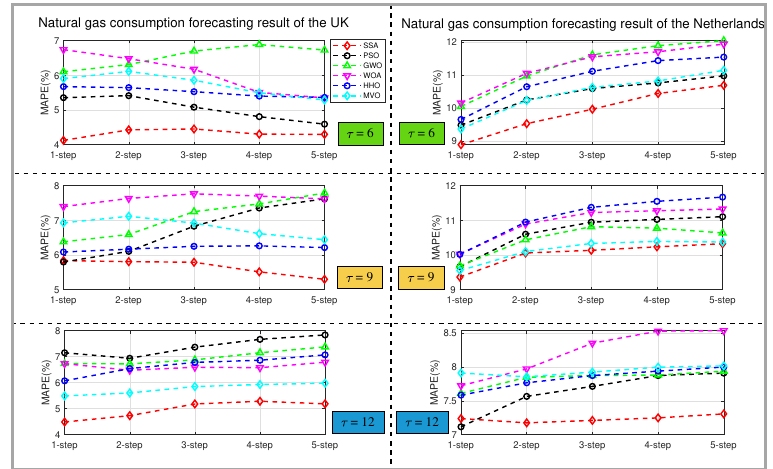
Figure 18. MAPE of models on different